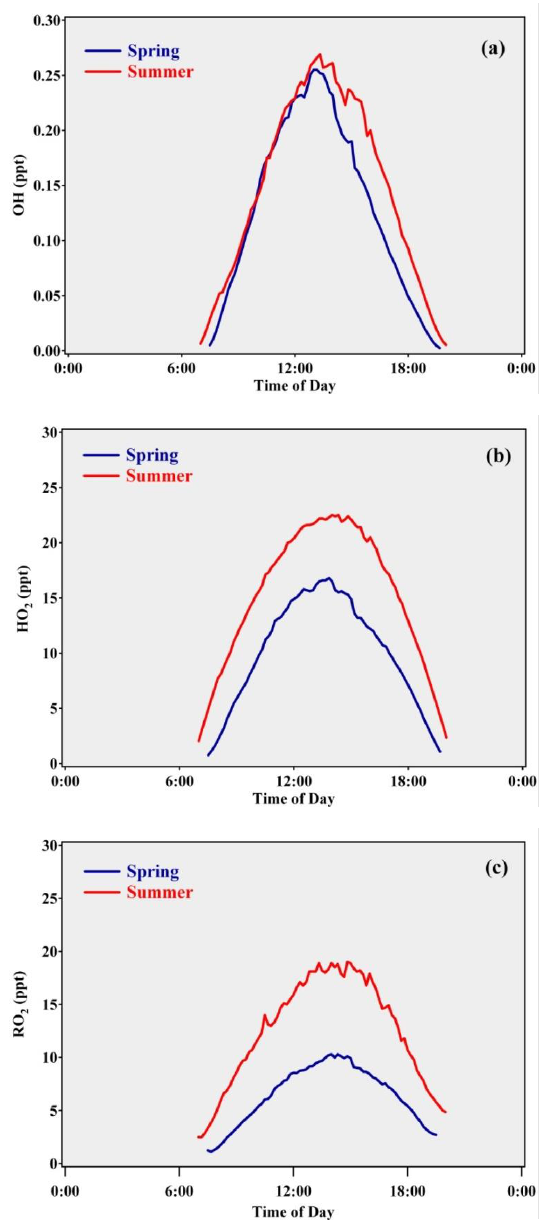
Figure 7 Fig. 7. Model-predicted daytime profiles of (a) OH, (b) HO